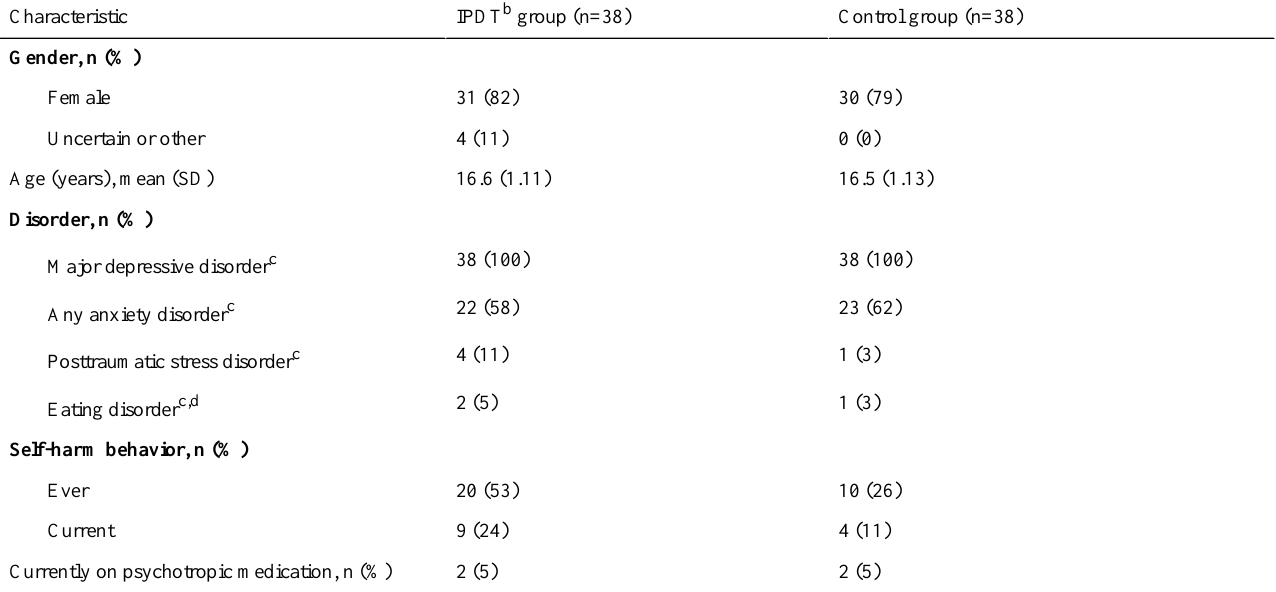
Table 1. Demographic data at baseline a